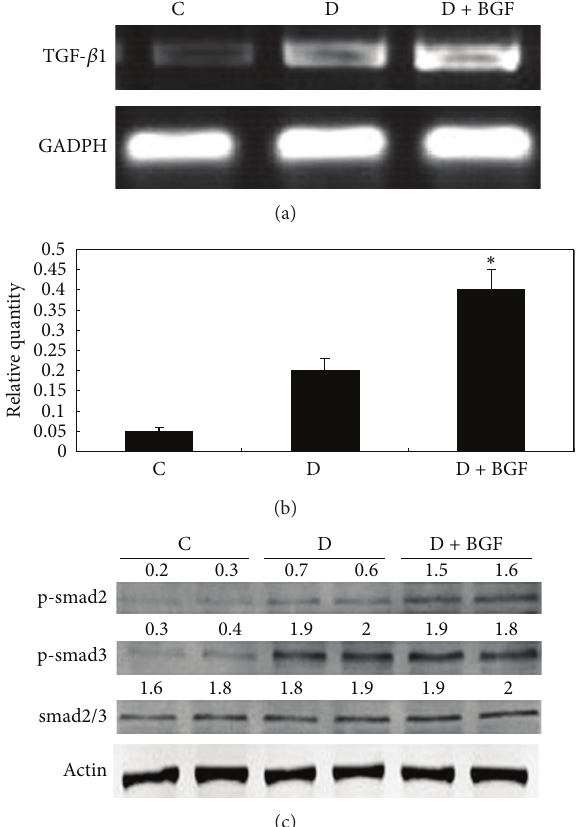
Figure 5: BGF treatment upregulated TGF- 𝛽 1 expression and activated TGF- 𝛽 1-induced smad signaling. (a) TGF- 𝛽 1 expression in the kidney of mice was evaluated by RT-PCR. (b) Data are expressed as the mean ± SEM of three separate experiments. ∗ 𝑃 < 0.05 as compared to the control. (c) The phosphorylated forms of smad2 and smad3 were analyzed by Western blot, using either rabbit anti-p-smad2 or rabbit anti-p-smad3 and total rabbit anti-smad2/3 antibody.